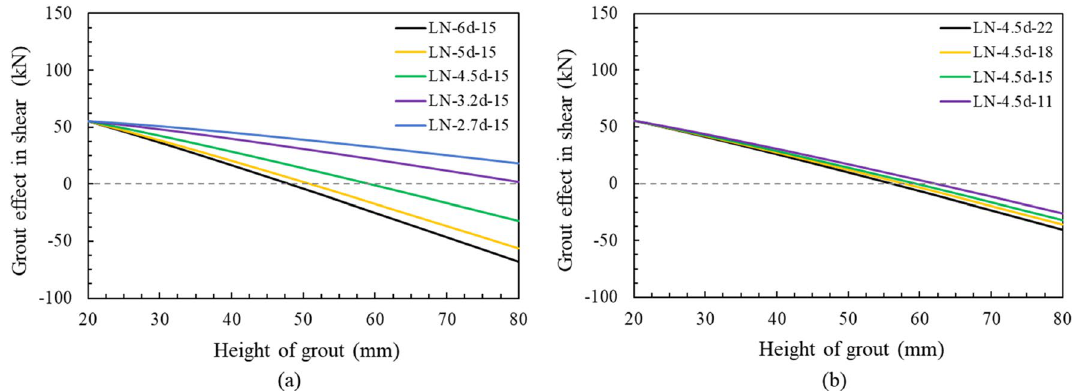
Figure 13. Grout effect in shear with different height of grout: ( a ) edge distance, ( b ) embedment depth.